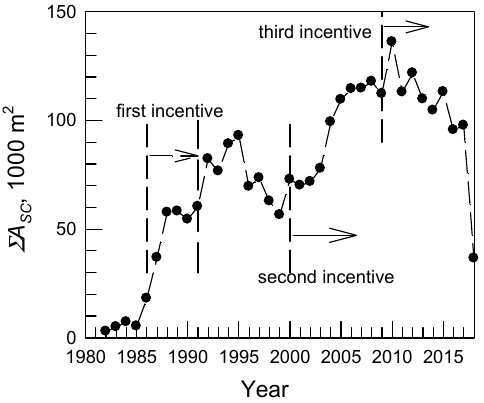
Figure 2. The annual area of solar collectors installed Σ A sc for Taiwan (1982–2018).